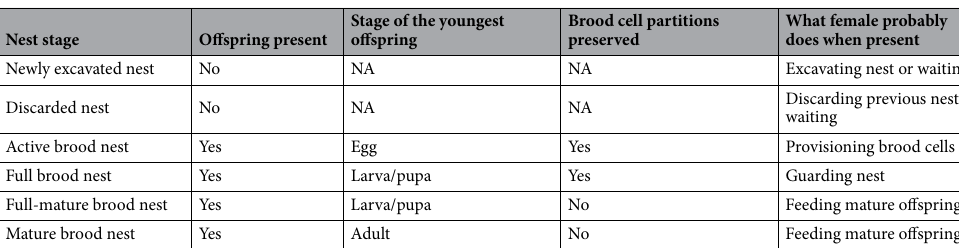
Table 1. Criteria for classification of nest stages. Last column is based on 31–33,54